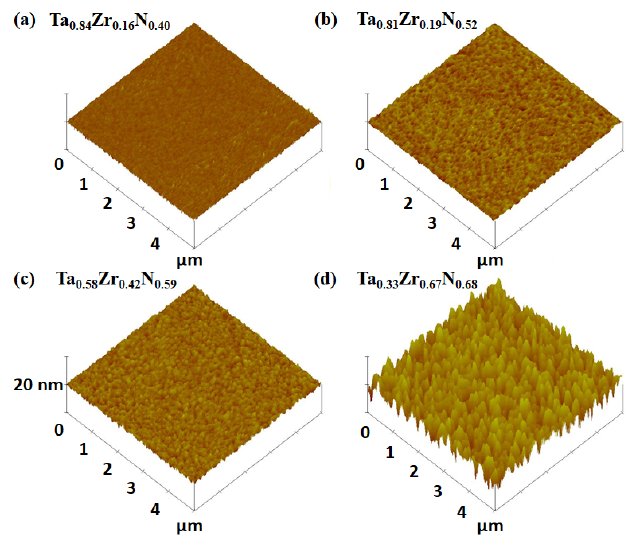
Figure 3. Atomic force microscopy (AFM) images of as ‐ deposited Ta–Zr–N thin films prepared on Si substrates. ( a ) Ta 0.84 Zr 0.16 N 0.40 ; ( b ) Ta 0.81 Zr 0.19 N 0.52 ; ( c ) Ta 0.58 Zr 0.42 N 0.59 ; ( d ) Ta 0.33 Zr 0.67 N 0.68 .